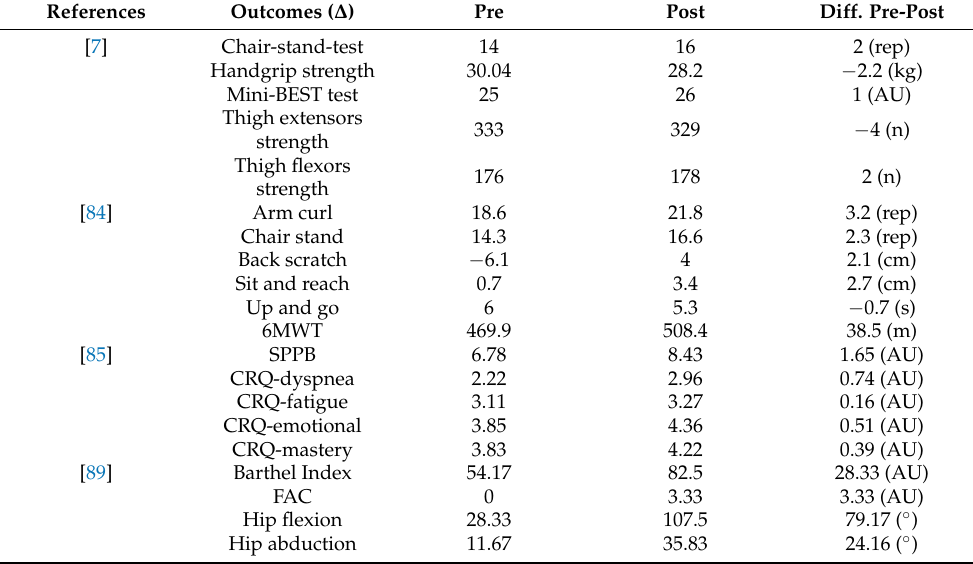
Table 8. The main outcomes of chronic diseases during